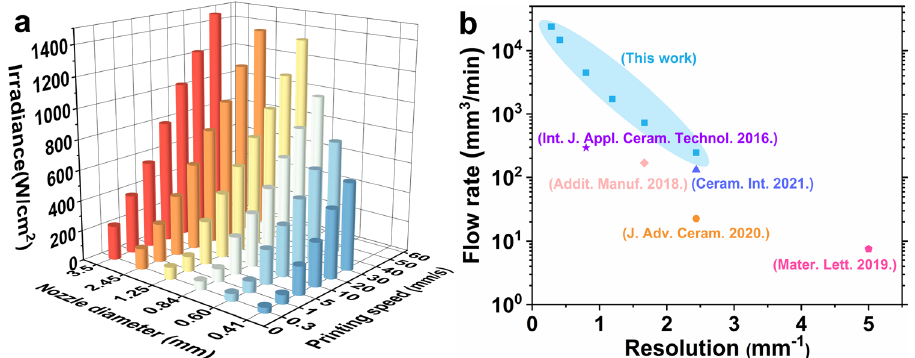
Fig. 3 | Throughput of NIR-DIW. a The effects of different NIR light intensities, printingspeedsand nozzlediametersoncuring.Nozzlediameterswereplottedon theabscissaforemphasis,printingspeedswereshownupwardintheordinate,with different NIR irradiance along the Z direction. Note that the required minimum